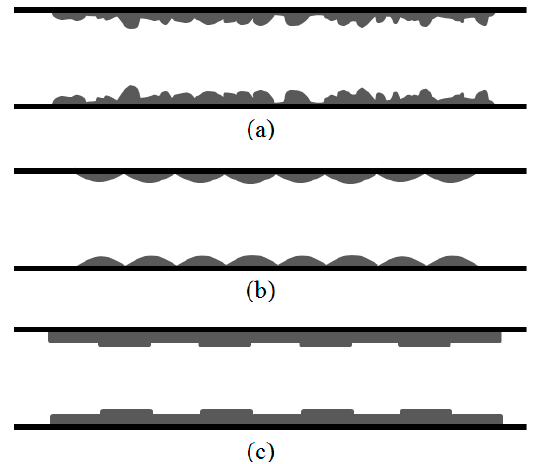
Figure 4. Sketch of different types of pipe diameter non-uniformities (side-sectional profile): ( a ) realistic and random situation; ( b ) regular approximation by sinusoidal variation; ( c ) regular approximation by step variation.